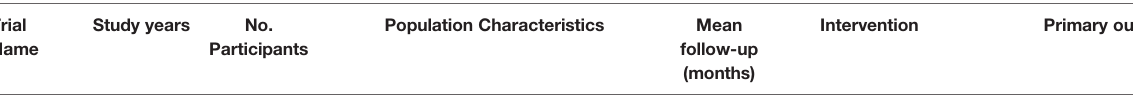
TABLE 2 | Landmark RCT ’ s in the surgical management of the